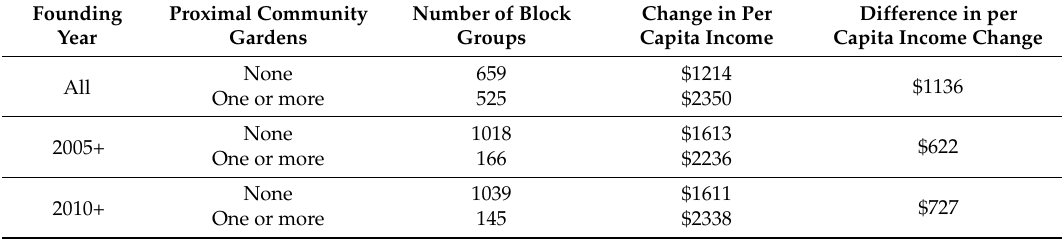
Table 1. Population-weighted average change in per capita income (2010–2015) based on ¼ mile proximity to community gardens (CG) for all gardens (all), those founded in 2005 or later (2005+), and those founded in 2010 or later (2010+).